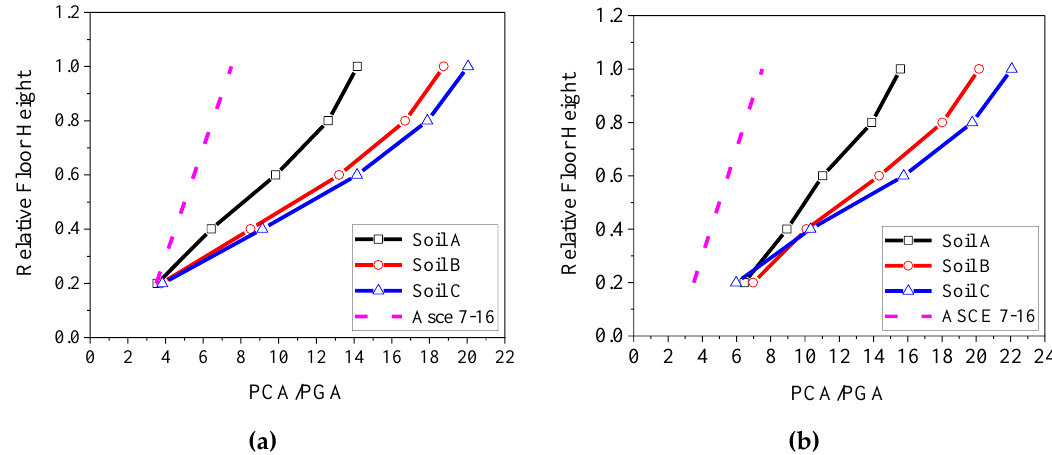
Figure 12. Normalized PCA values for ( a ) regular buildings; ( b ) irregular buildings.